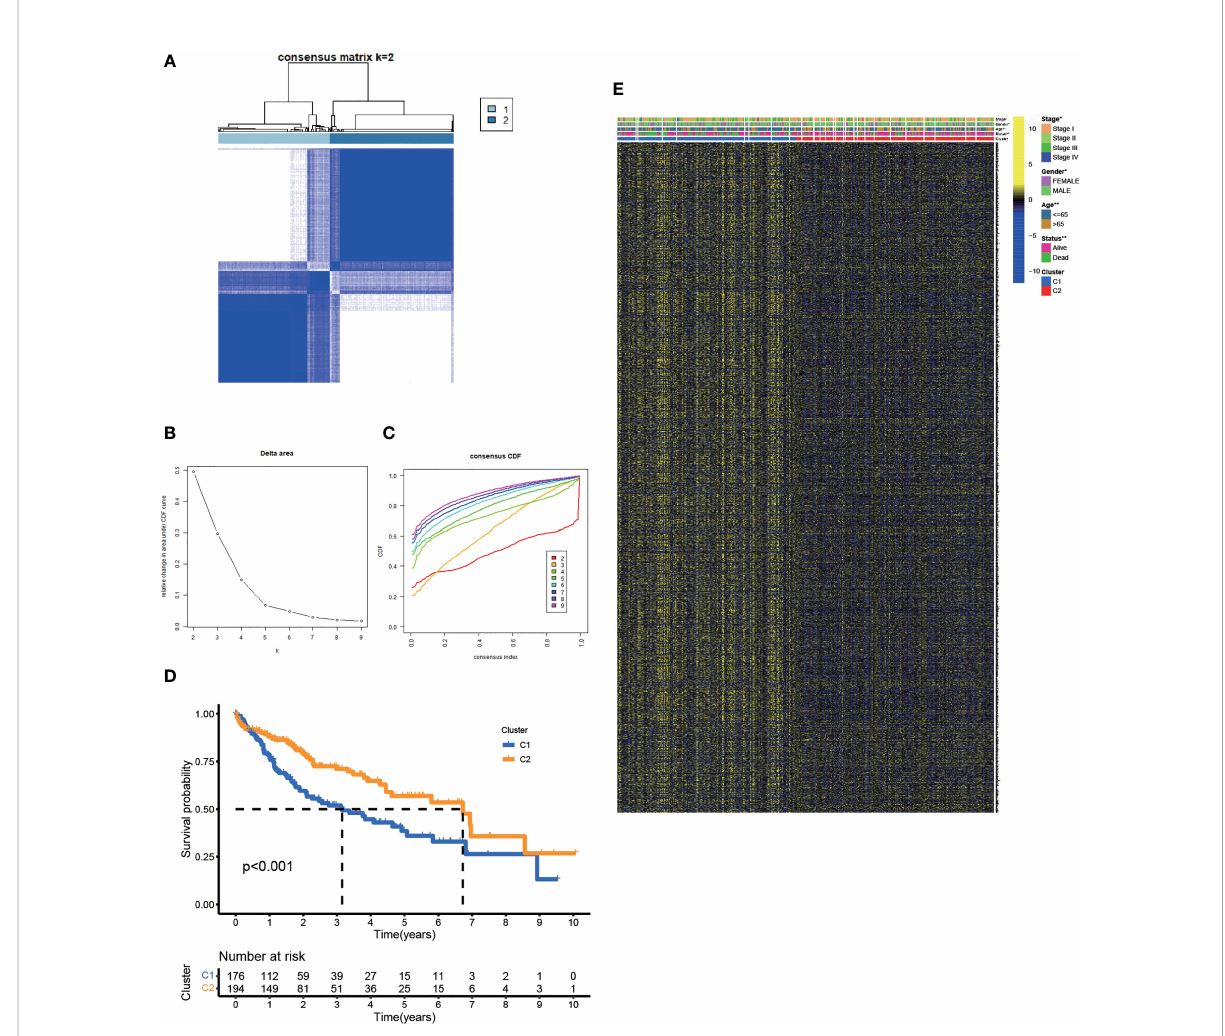
FIGURE 2 Clustering, Construction of HCC Classi fi cation According to Genes associated with FA Metabolism. (A) Patients were classi fi ed into two subtypes according to the consensus clustering matrix. (B, C) Consensus clustering model. (D) The KM analysis of the OS in the two subtypes. (E) Heatmap showed the correlation between the subtypes and clinicopathologic parameters (*p < 0.05, **p < 0.01, ***p <